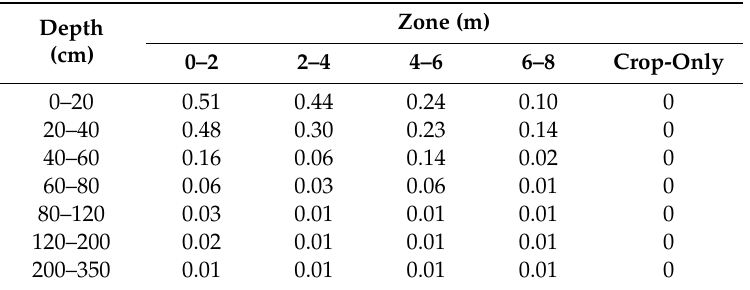
Table 2. Measured tree root length density (cm cm − 3 , unpruned) values used to set up the model. Root length densities were reduced by an assumed 25% in the 50% pruned treatment and by 50% in the 100% pruned treatment.